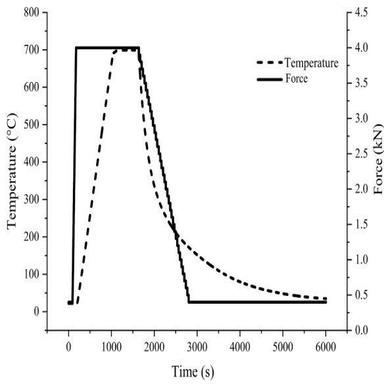
Force/temperature versus time graphs obtained during the SPS process.